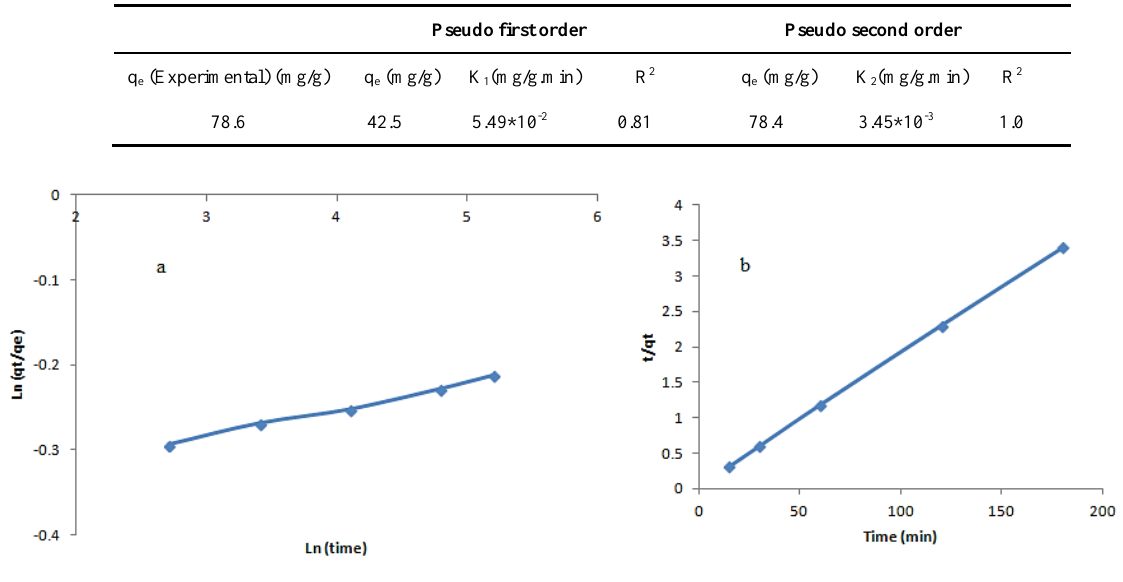
Figure 5. The kinetic data a) pseudo first order; b) pseudo second